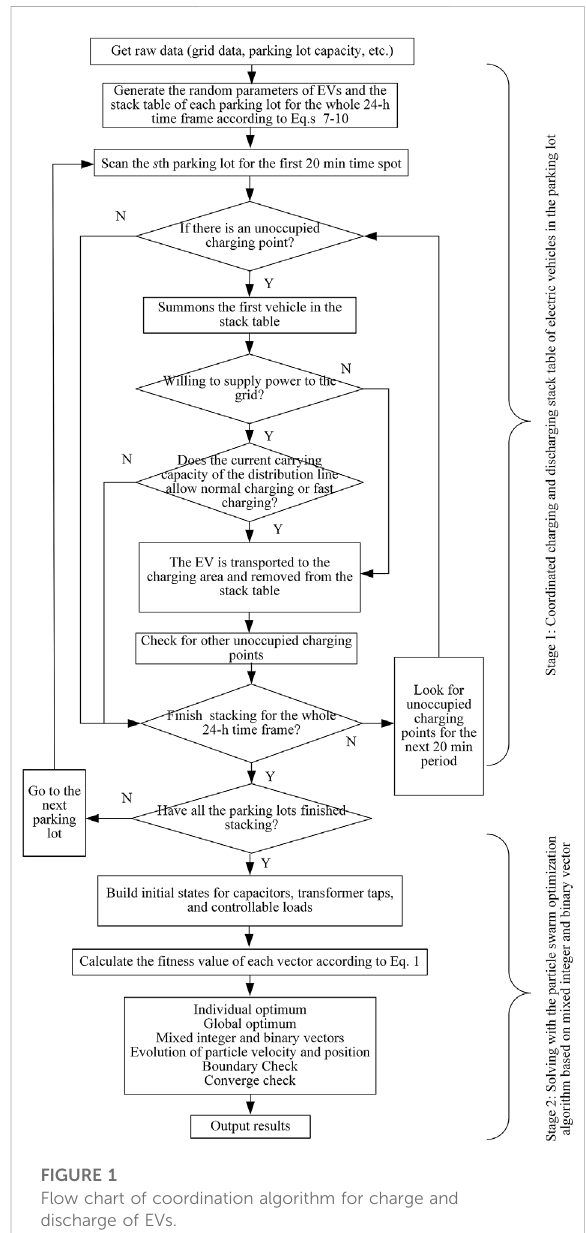
FIGURE 1 Flow chart of coordination algorithm for charge and discharge of